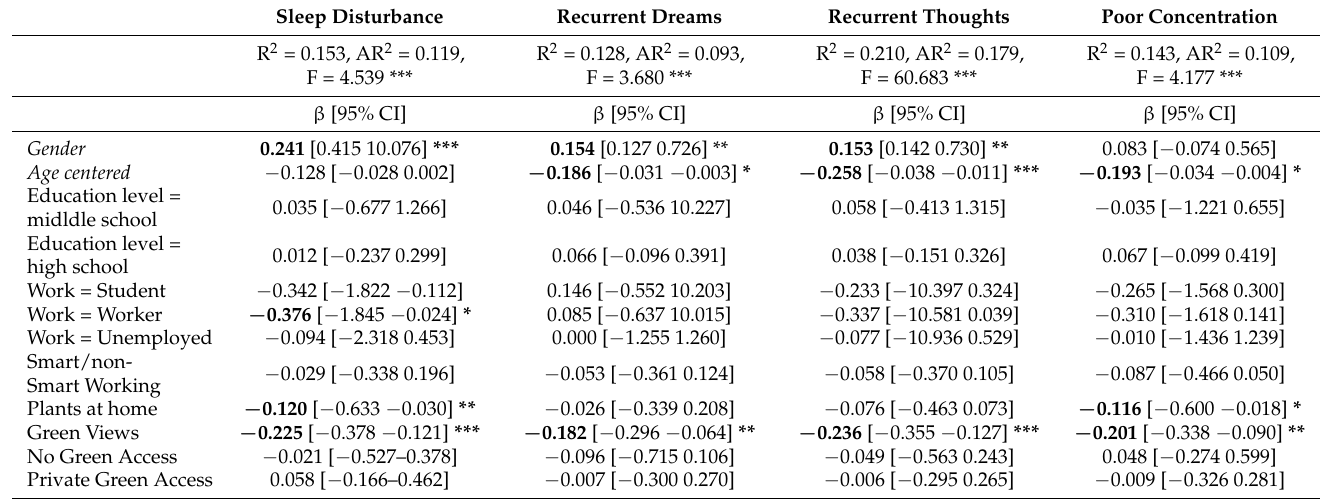
Table 4. Results of single-exposure regression models of the associations between nature exposure and the significant health